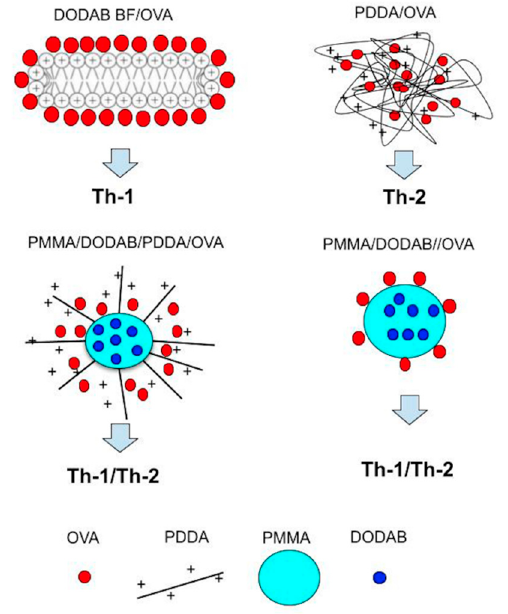
Figure 8. Cationic nanostructures from biocompatible polymer and cationic lipid and/or cationic polymer.